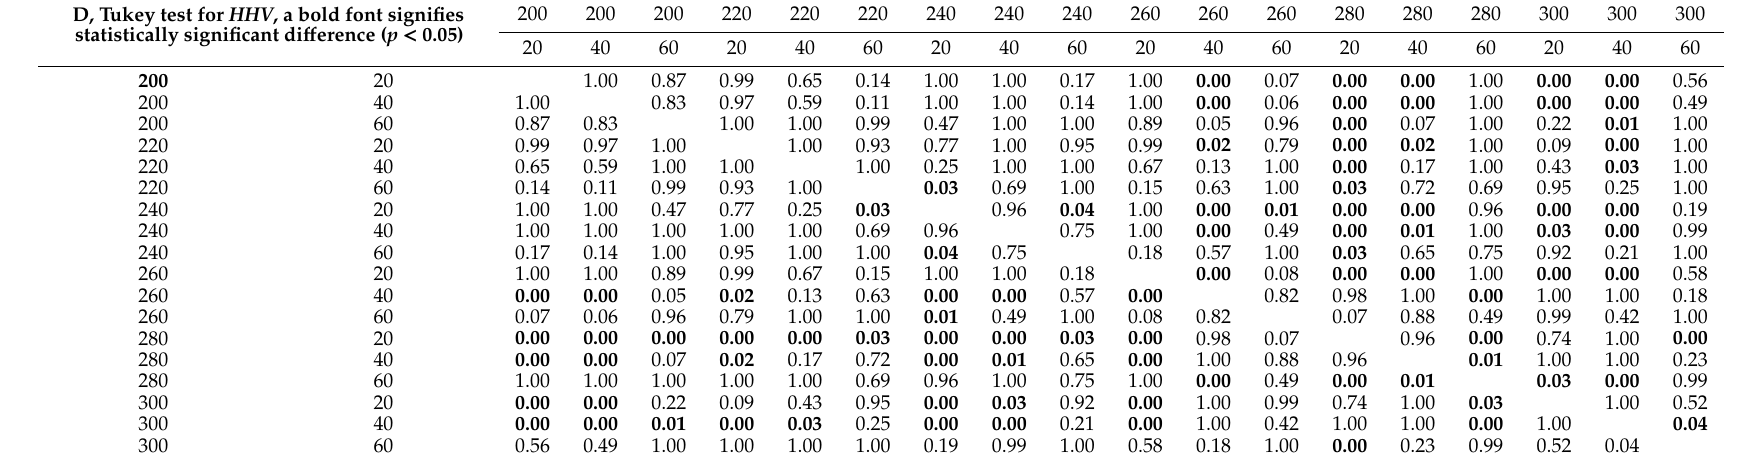
Table A15. Analysis of variance for HHV of